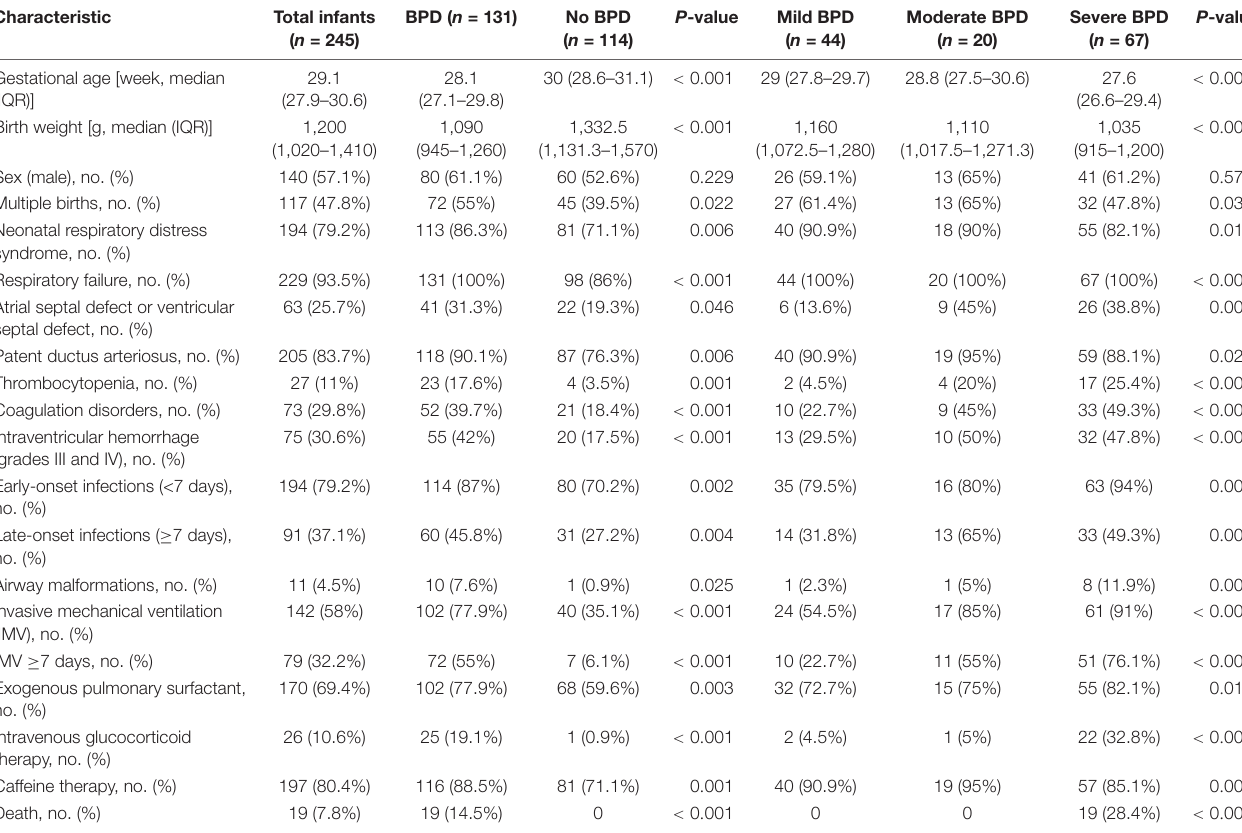
TABLE 1 | Clinical characteristics of 245 premature